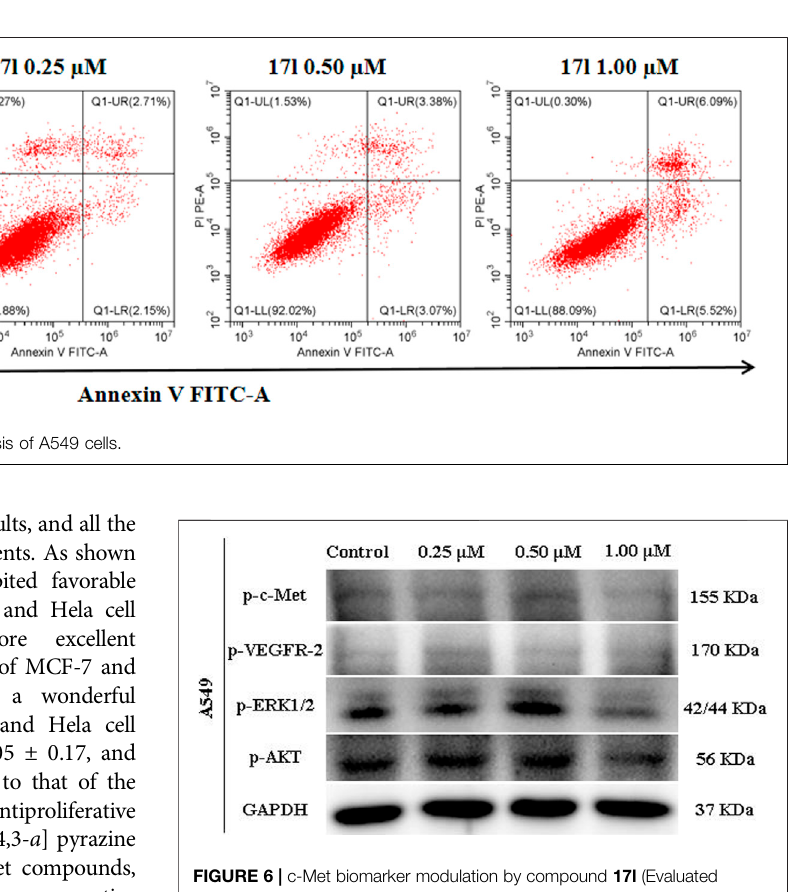
methylthiazole ring had better antiproliferative activity on the